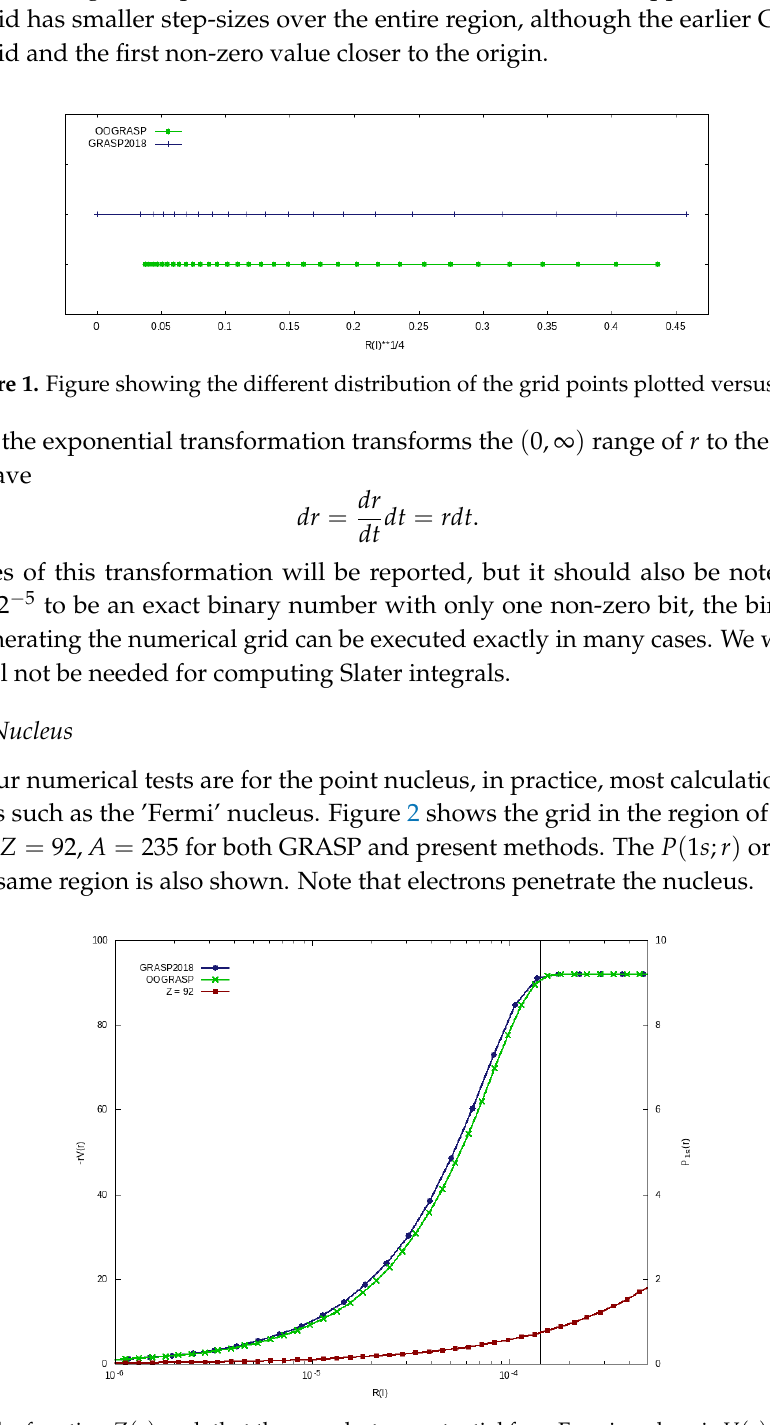
Figure 2. The function Z ( r ) such that the one-electron potential for a Fermi nucleus is V ( r ) = − Z ( r ) / r . P ( 1 s ; r ) is also shown in the region of the